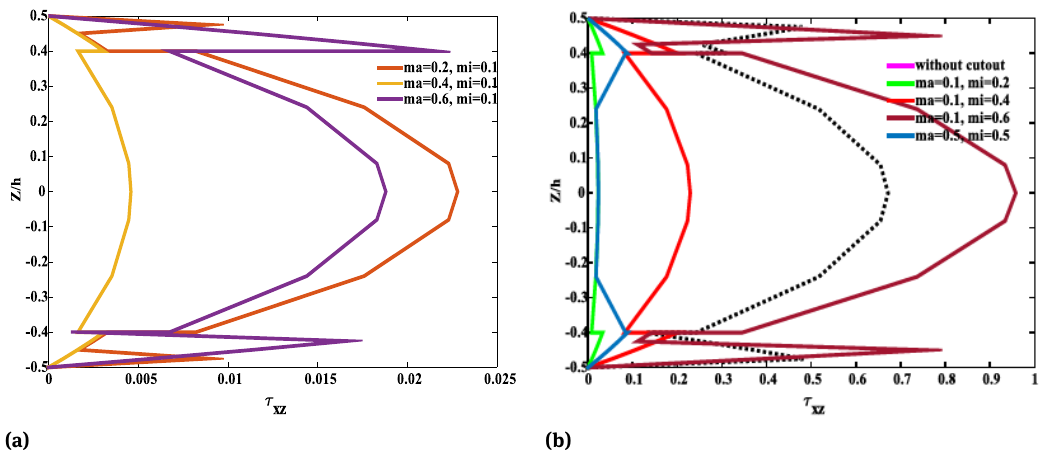
Figure 13: (a) and (b) distribution and comparison of τ xz along the thickness of LCSP having different cutout Table 2: Validation study for square sandwich plate (0/C/0) of a/h=10 with simply supported edges under uniform